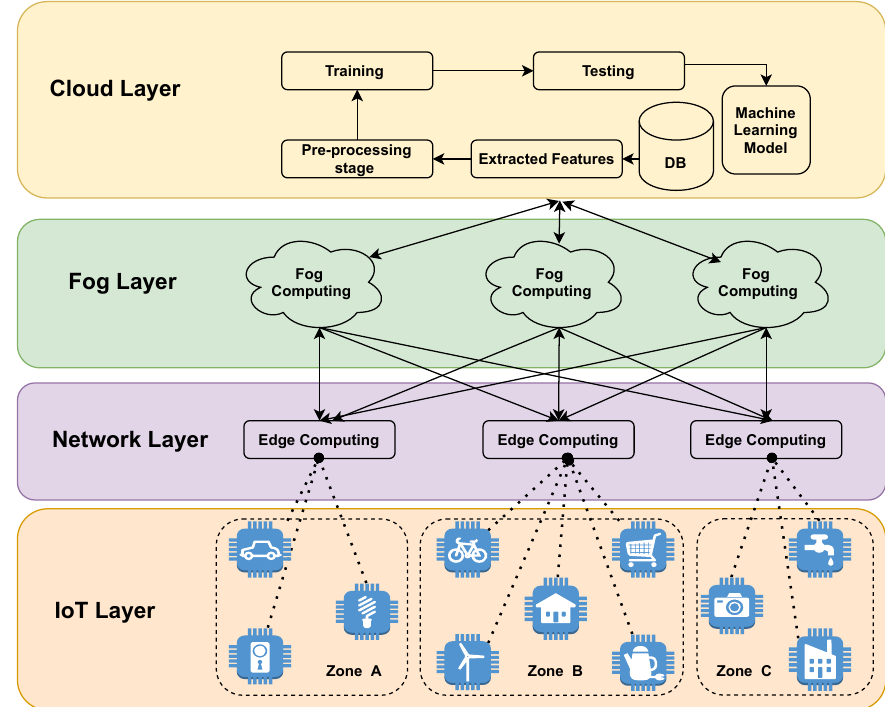
Figure 4. Architecture of CoLL-IoT Detection System.